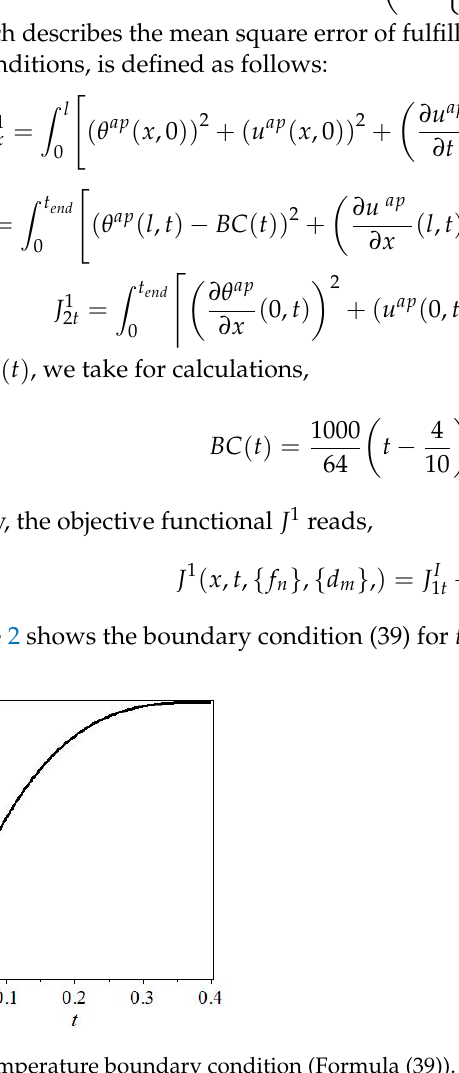
Figure 2. Temperature boundary condition (Formula